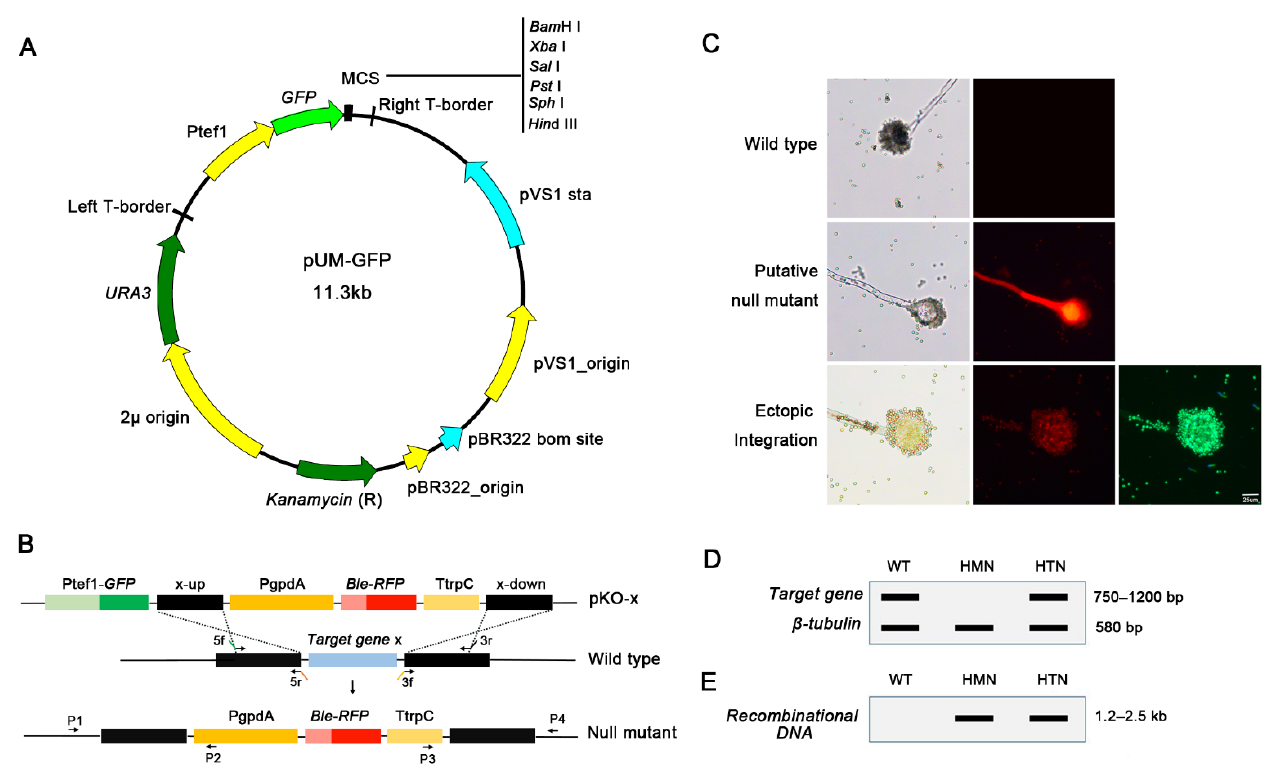
Figure 2. Gene knockout strategy in Aspergillus flavus . ( A ) Features of the yeast– Escherichia – Agrobacterium shuttle vector pUM-GFP. ( B ) Construction of the double fluorescence knockout vector pKO-x and deletion of the targeted gene (x) by homologous recombination in the fungi. ( C ) The transformants were screened by double fluorescence. Putative mutants have RFP fluorescence; ectopic transformants have both GFP and RFP fluorescence, and the wild-type lacks fluorescence. Bar = 25 μ m. ( D ) Negative double PCR to identify the null mutants with homogeneous nuclei (HMN) using the β -tubulin gene as a positive control. ( E ) HMN mutants were verified by positive PCR for a unique recombinational DNA fragment. GFP, green fluorescent protein; HMN, homogeneous nuclei; HTN, heterogeneous nuclei; RFP, red fluorescent protein; WT, wild-type.